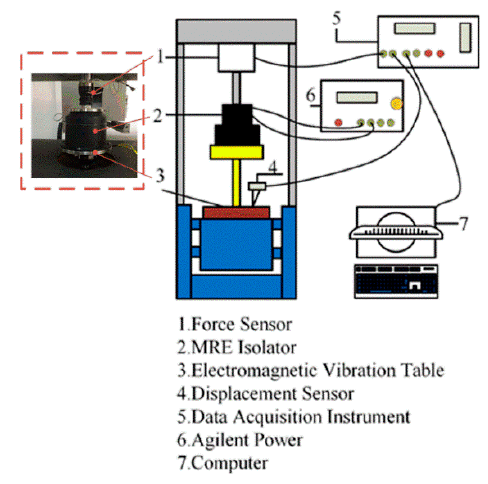
Figure 2. Experimental setup for characterizing MRE isolator.